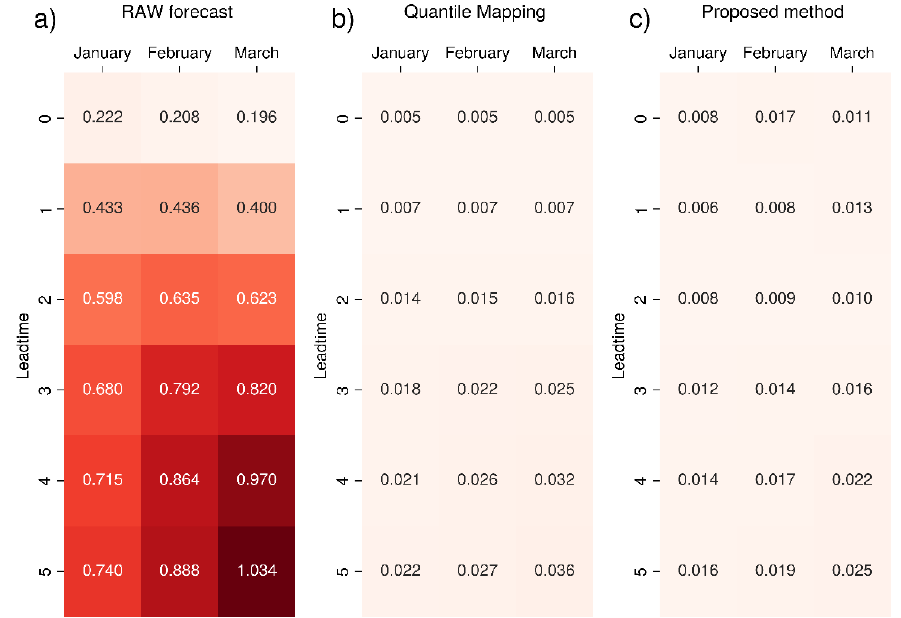
Figure 7. RMSE (m) of the total precipitation 99th percentile value for seasonal forecast GCFS2.1 (DWD) compared to ERA5 reanalysis: ( a ) raw data, ( b ) data corrected standard with quantile mapping and ( c ) data corrected with the proposed bias correction method. The colour scale ranges from white (RMSE = 0) to dark red, increasing in intensity as the metric increases. The most intense colour corresponds to the maximum value.